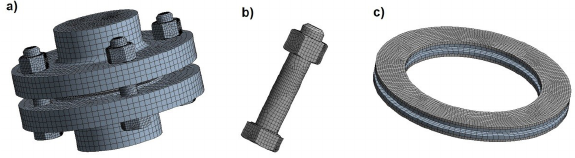
Figure 9: Geometric model of the joint and its finite element mesh